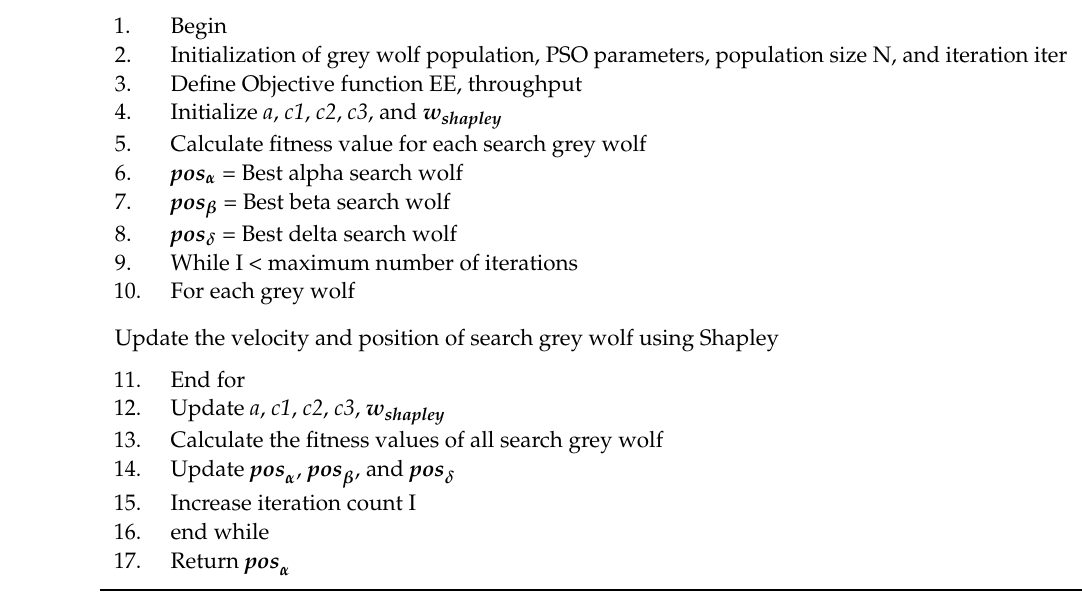
Algorithm 1: Shapley hybrid multi-objective optimization algorithm